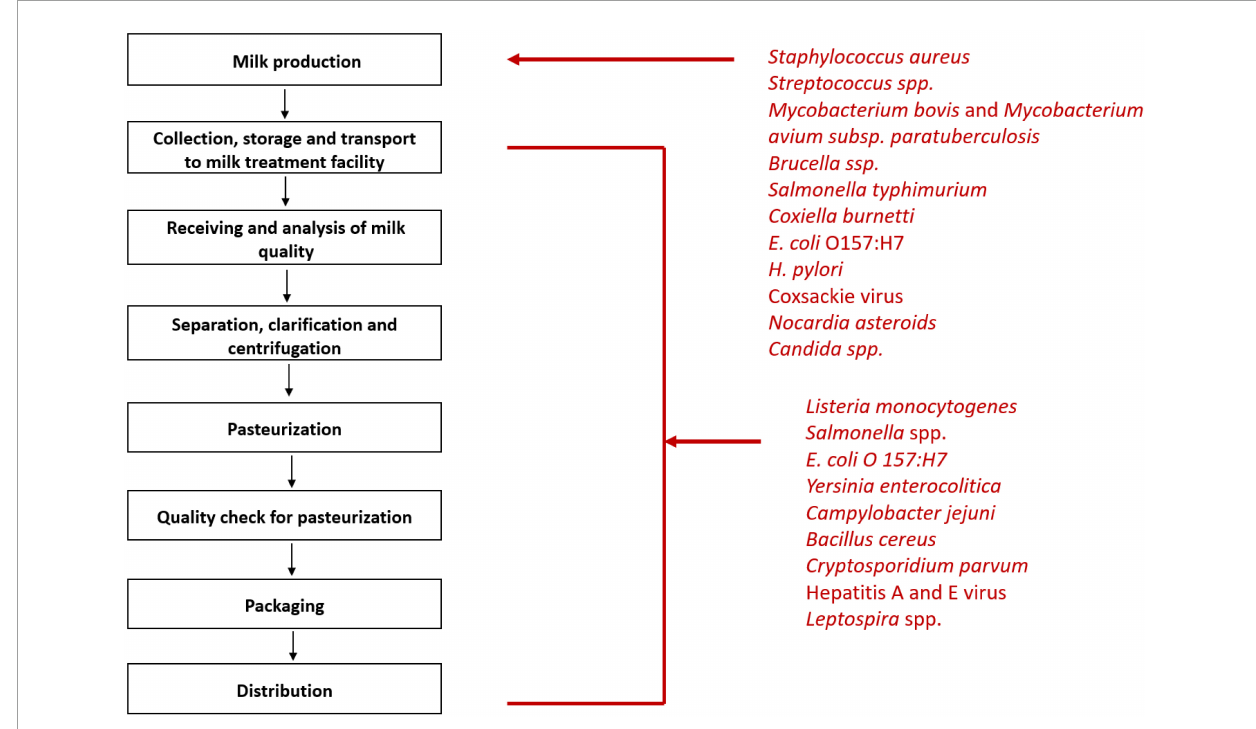
FIGURE1 Steps of milk processing and list of pathogens that can enter milk at various stages of